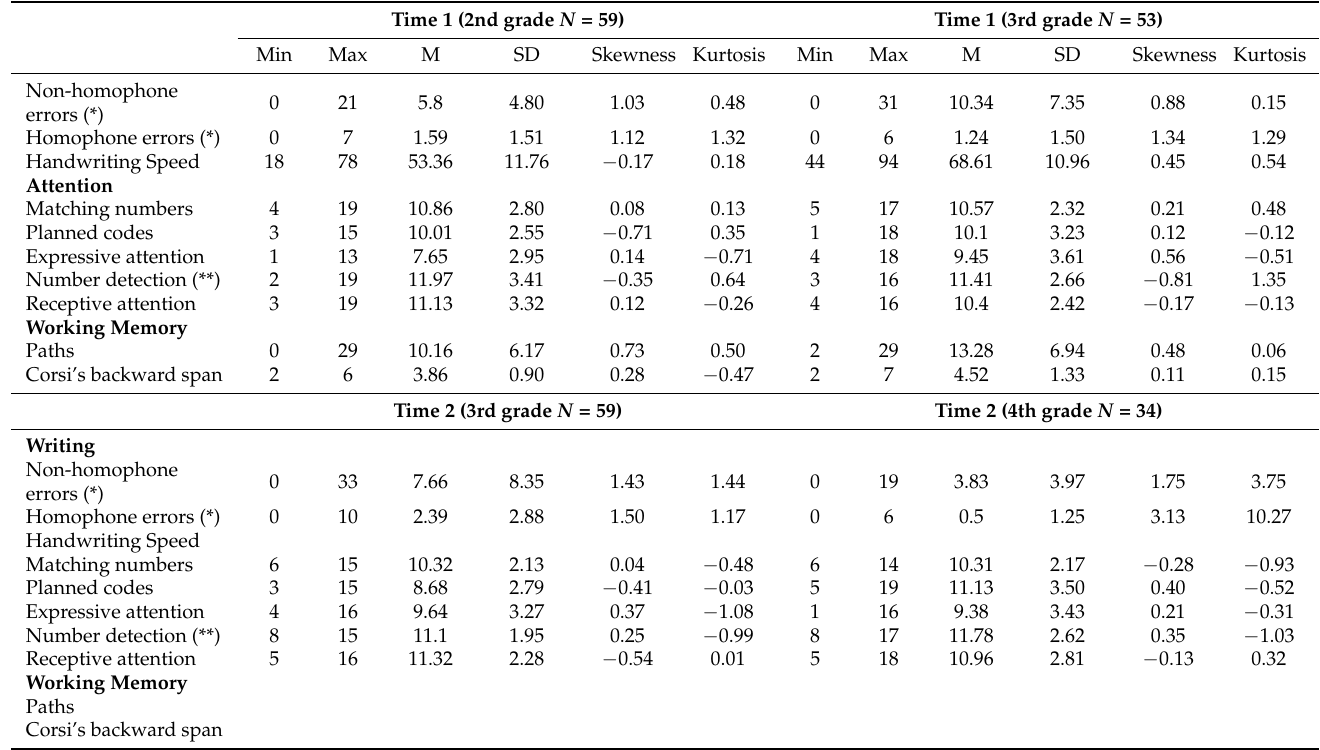
Table 1. Descriptive statistics of all measures about writing, attention, and visuo-spatial working memory skills in 2nd and 3rd grades (T 1 ) and in the next year (T 2 ): minimum, maximum, mean, standard deviation, skewness, and